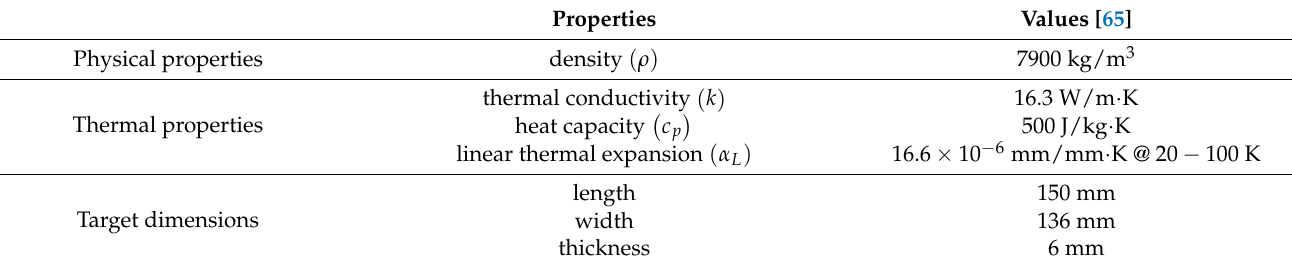
Figure 4. Checkerboard targets fabricated using ( a ) SLTL’s Akshar Fiber Pro Ultra laser engraving machine and ( b ) Canon’s Arizona 1380 XT fl atbed UV printer. Table 2. Physical and thermal properties of the SS304 calibration plate. Properties